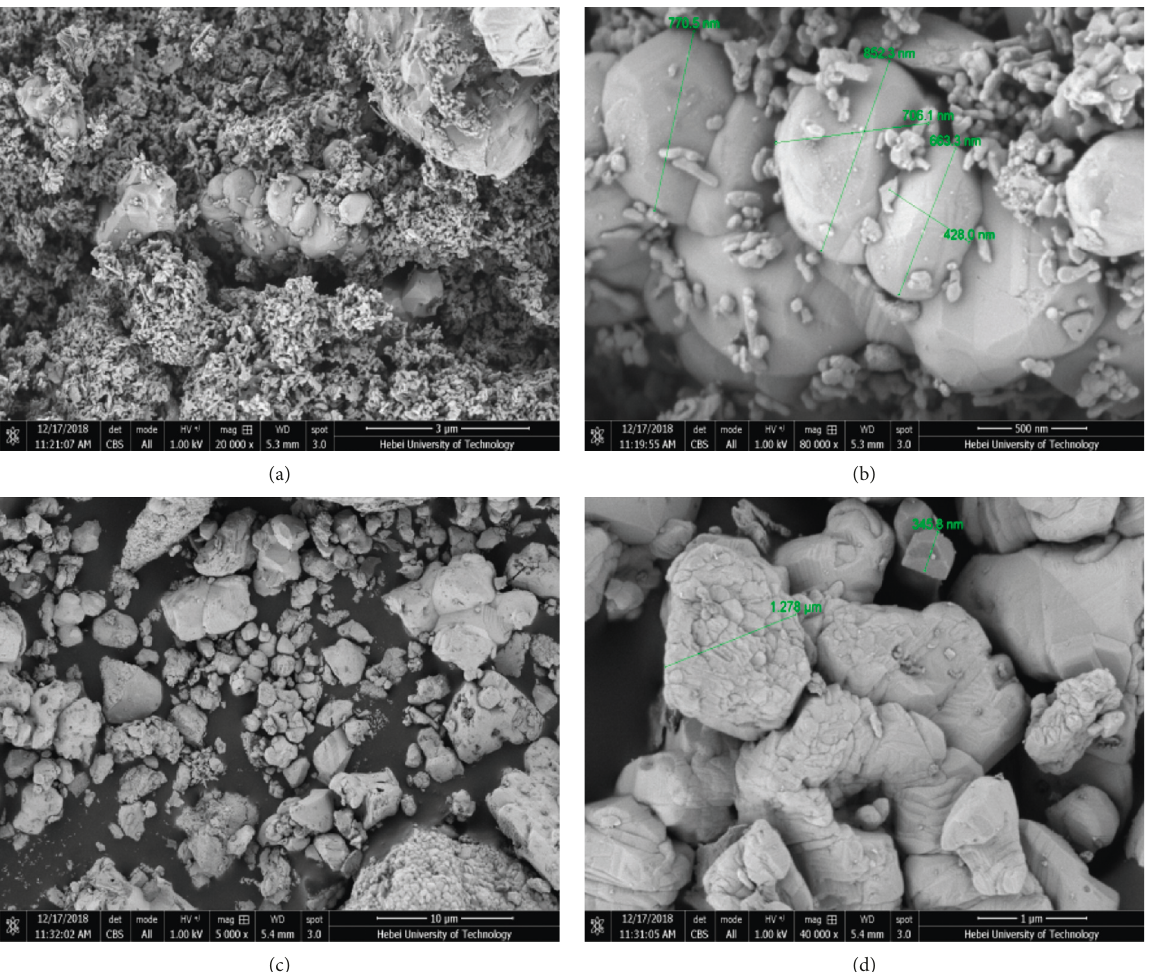
Figure 1: SEM images of (a, b) La 2 O 3 (500nm) and (c, d) Fe 2 O 3 (1000nm).